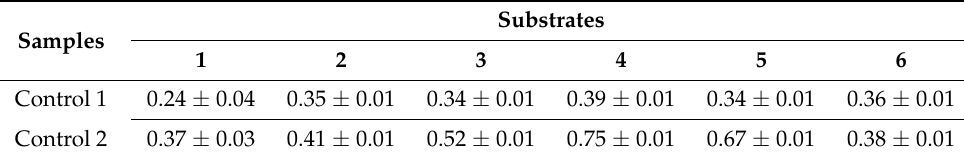
Table 2. A. niger cellulolytic activity (concentration of the reducing substance, mg/mL) in different substrates.